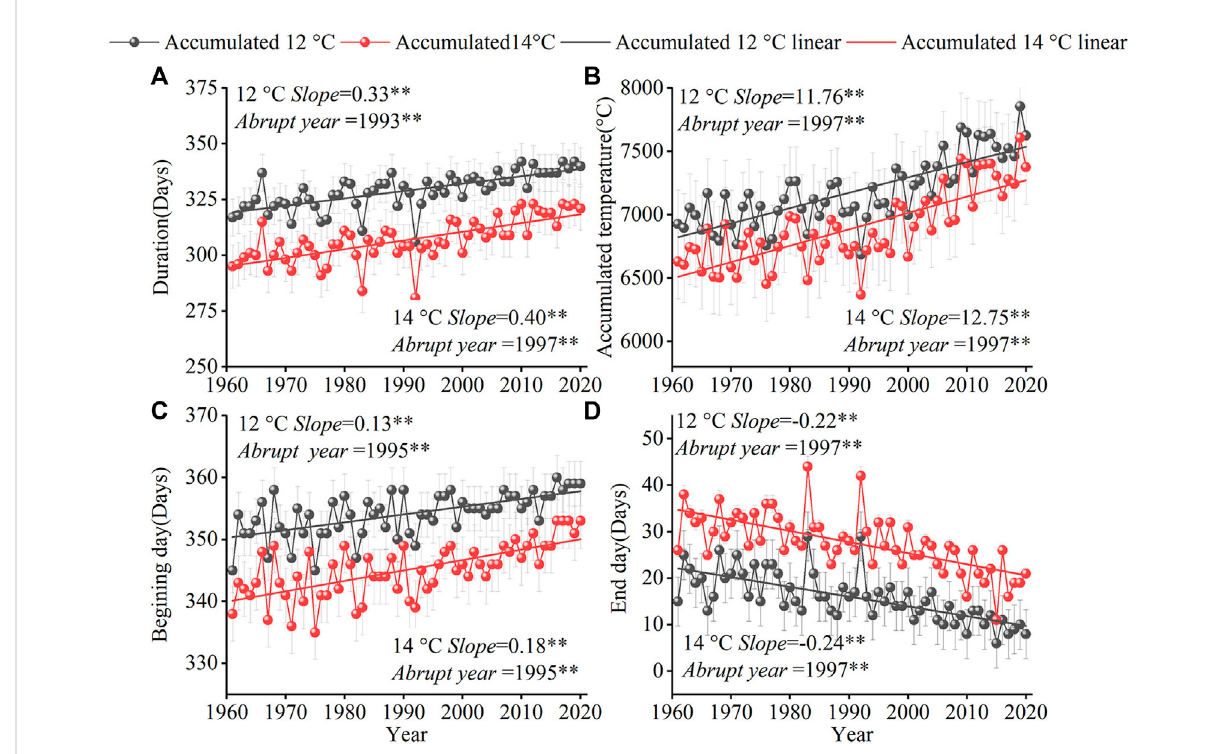
FIGURE 13 Temporal variation of (A) beginning date, (B) end date, (C) duration, and (D) accumulated temperature of daily soil temperature ≥ 12 and 14 ° C at 5-cm